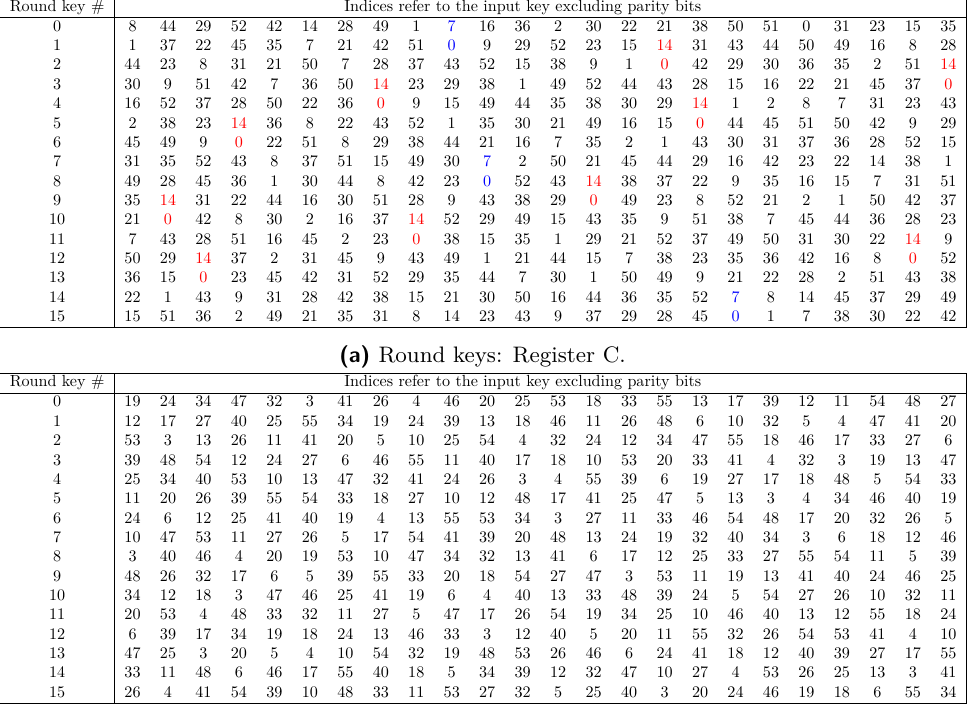
Figure 5: DES round keys in parts C and D. Two bit pairs are highlighted in red and blue to illustrate the reoccurrence of transitions.